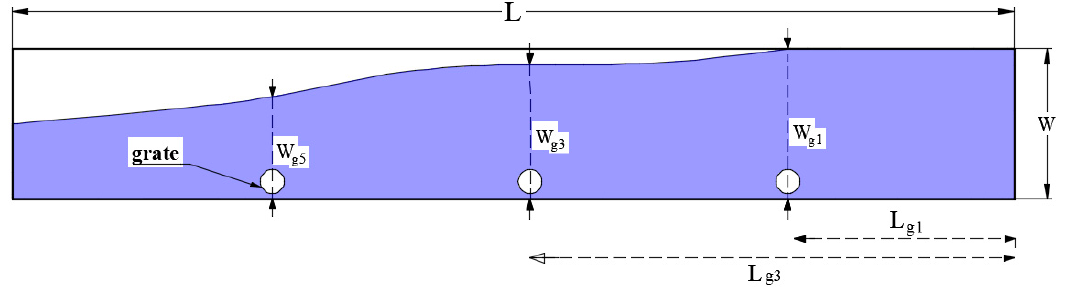
Figure 2. Plan of flume and arrangement of grates.